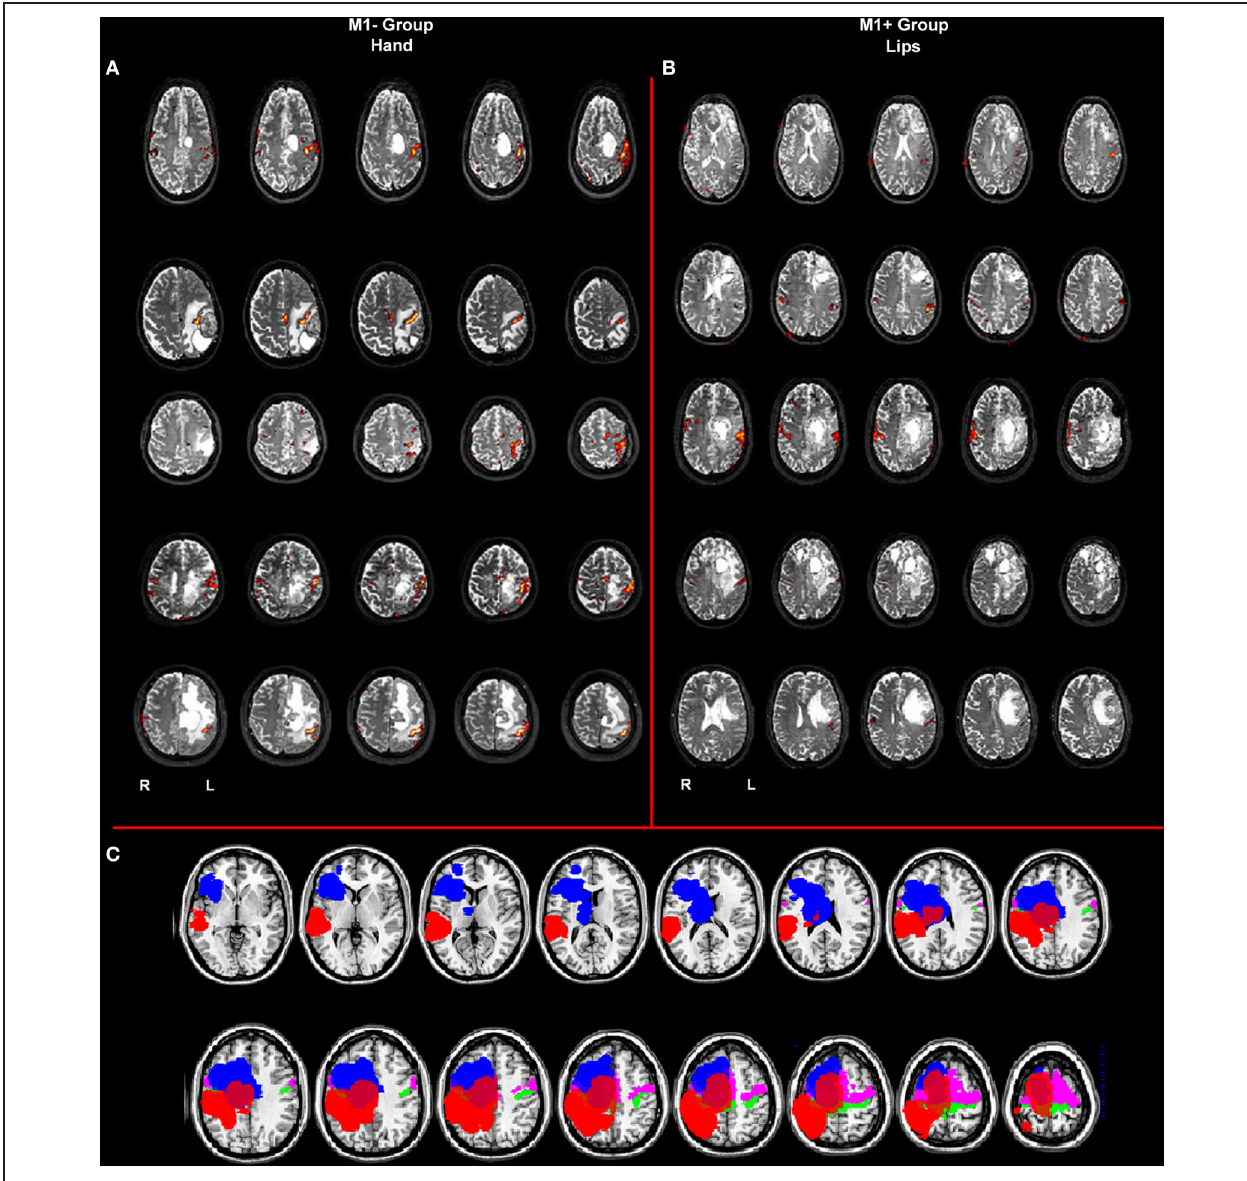
FIGURE 1 | (A) Whole brain analysis results for the group of patients with lesionsinvolving M1(M1 − ) performing handclenching movements vs.restand (B) activation maps for the group of patients with lesions sparing M1 (M1 + ) performing lip movements vs. rest. The two types of movement have been selected in this image to highlight the close location of the M1 − to the hand representation area, as evidenced by the activation cluster, and the vicinity of